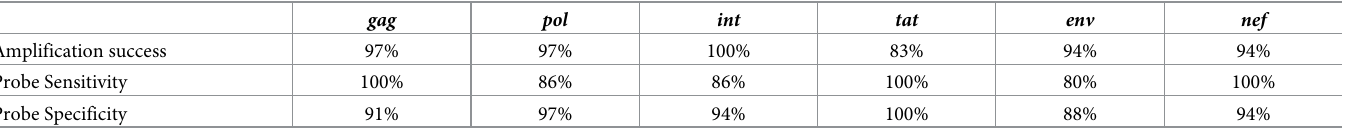
Table 1. MHA B/non-B validation subtype reference panel results.